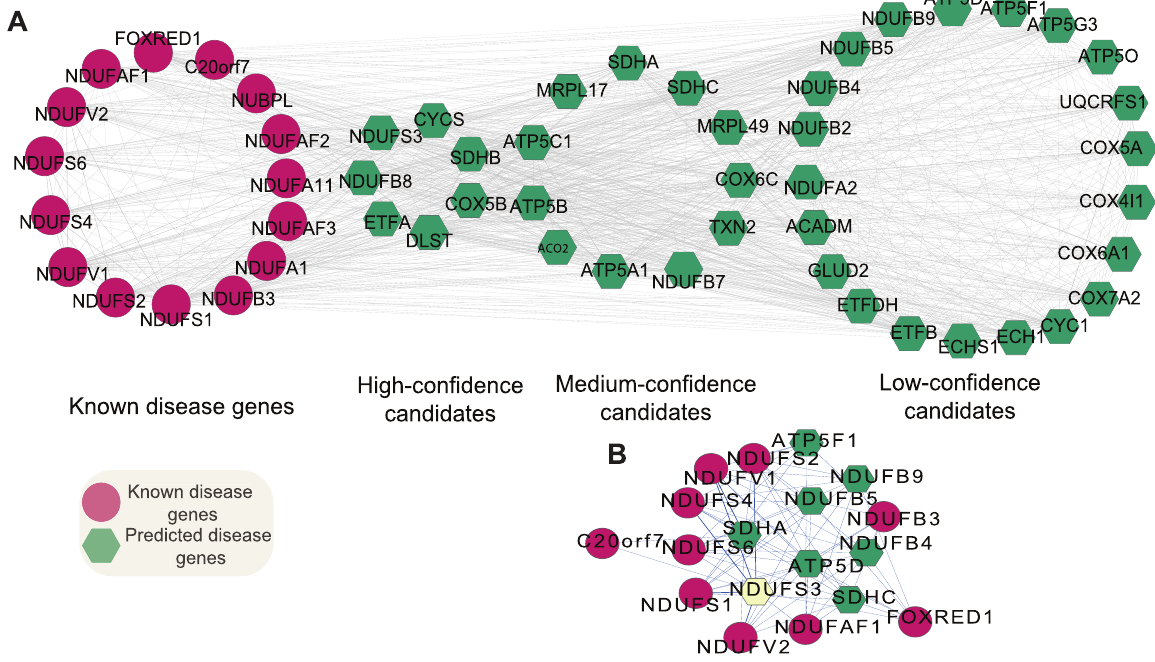
Figure 6. Prioritization results for mitochondrial complex I deficiency. (A) A hypothetical FLN of mitochondrial complex I deficiency. The FLN is comprising of known disease genes (highlighted in red) annotated in OMIM and predicted disease genes (highlighted in greed). The candidates are classified into three levels (high-confidence, middle-confidence and low-confidence) according to their ranking scores. (B) The functional linkage sub-network among the candidate NDUFS3 that has a top score on ranking algorithm for mitochondrial complex I deficiency.